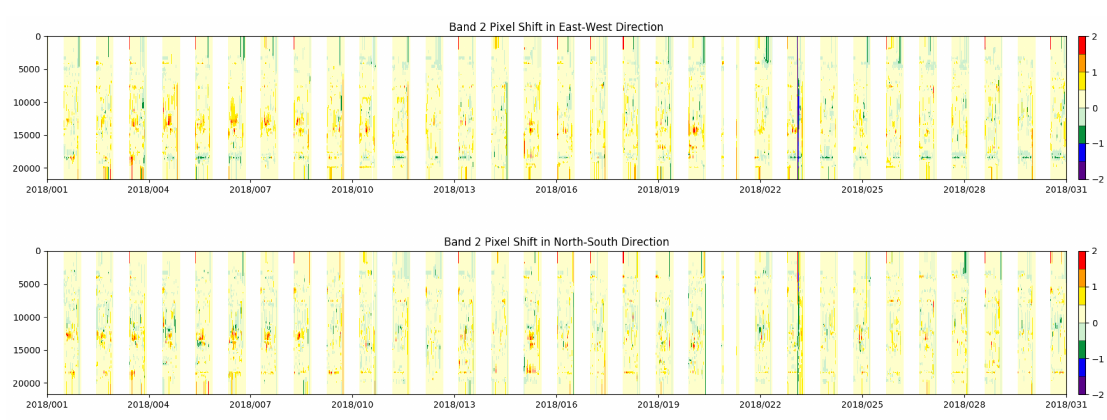
Figure 6. Spatial-temporal plots of the geolocation errors of GOES16 ABI L1b data from 1 January 2018, 00:00 UTC to 31 January 2018, 23:45 UTC. The top and bottom panels show the errors in the west-east direction ( ∆ c ) and the north-south direction ( ∆ l ), respectively. In either panel, the vertical axis indicates the line numbers of the full disk image, increasing from the top to the bottom. The horizontal axis represents the time dimension at a 15 min resolution. The color scheme indicates the geolocation errors in units of pixels. Nighttime data (with regard to the center of the image) are masked out in white. The geolocation errors are calculated based on the Band 2 (0.64 µ m) TOA spectral